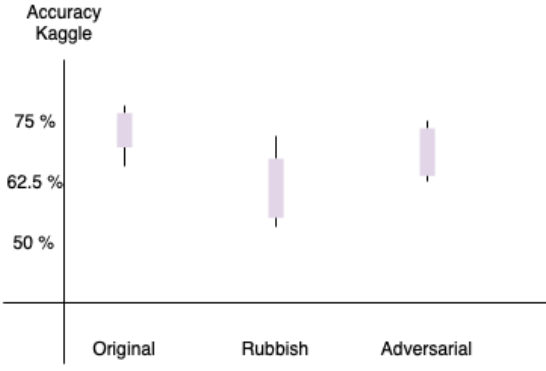
Figure 17. Sensitivity analysis showing candle chart of original method versus rubbish and adversarial